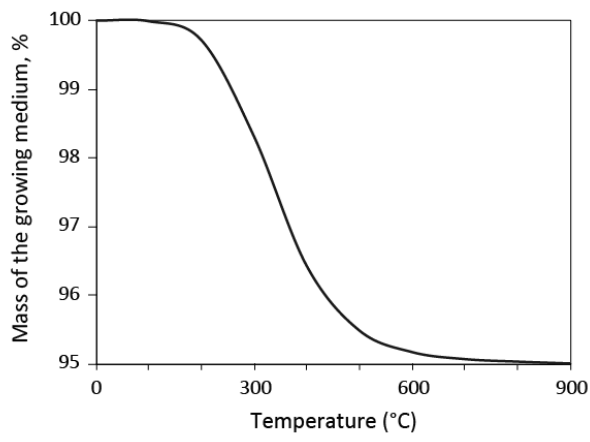
Figure 3. The loss of organic matter (OM) in the growing medium with respect to temperature. The structure parameter was obtained with the equation of Côté and Konrad [20]: